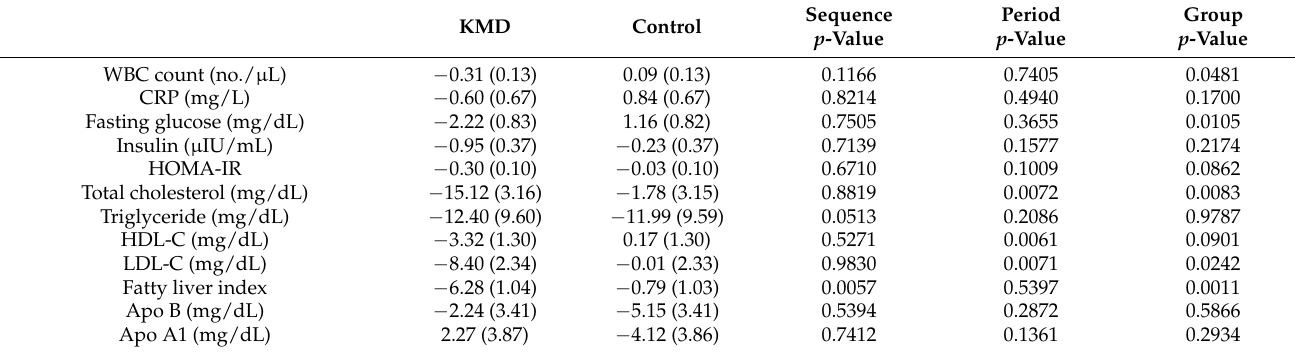
Table A4. Comparison of metabolic parameters according to diet type after adjusting weight reduction change.